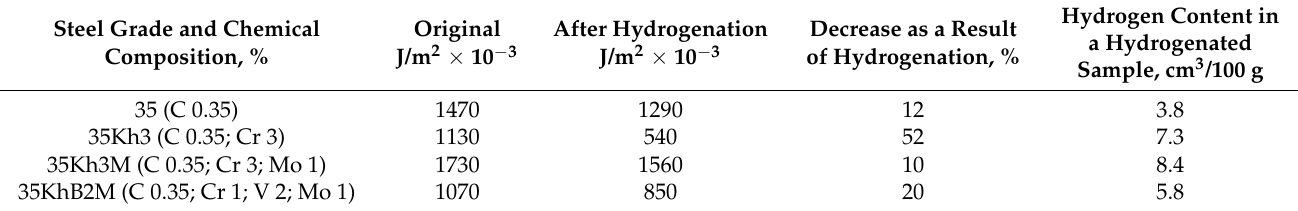
Table 7. Values of steel impact strength before and after hydrogenation [26].